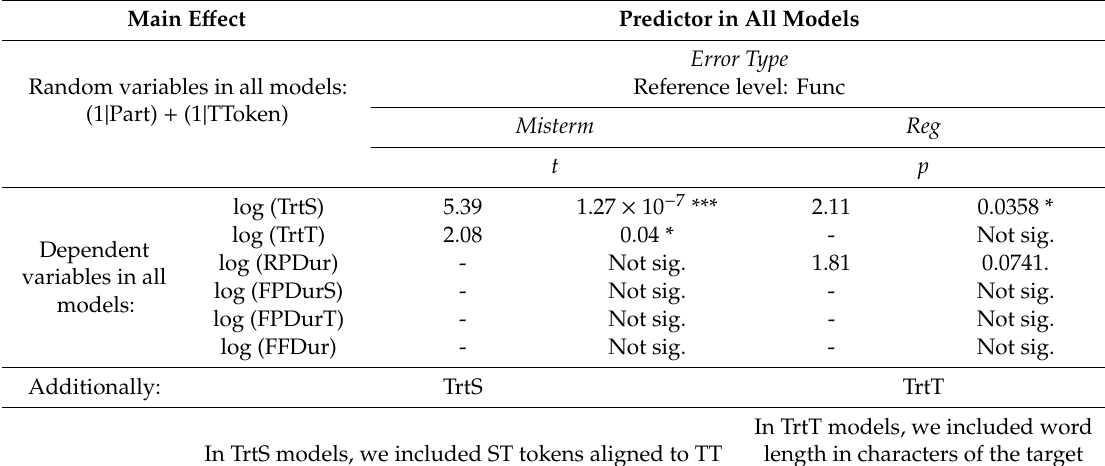
Table 6. T-values and significance intervals ( p ) for the main e ff ects of Error Type on the dependent variables. Main E ff ect Predictor in All